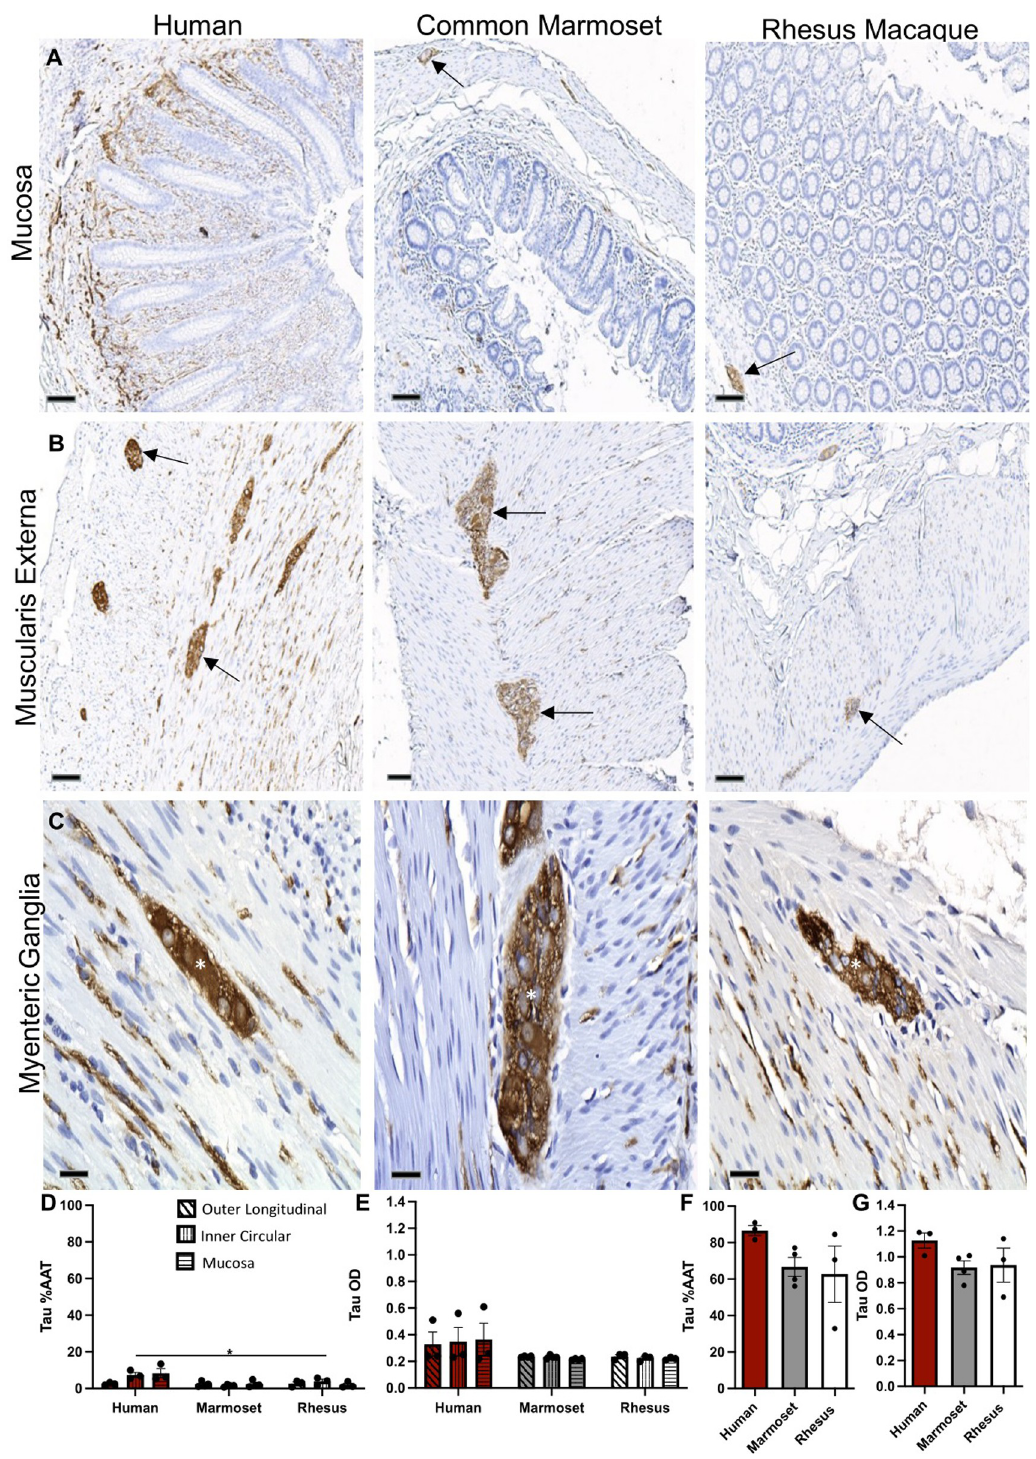
Fig 4. Tau expression in the appendix/cecum across species. Images of tau-immunoreactivity (-ir) (brown) in the (A) mucosa (arrows), (B) muscularis externa (arrows) and (C) myenteric ganglia (asterisks) from human appendix, common marmoset and rhesus ceca tissue sections counterstained with hematoxylin (blue). Graphs (mean ± SEM) of tau-ir (D,E) in gastrointestinal layers and (F,G) myenteric ganglia across species. Scale bar; a, 100 μ m; b, 100 μ m; c, 25 μ m. Abbreviations: %AAT, percent area above threshold; OD, optical density. � p <